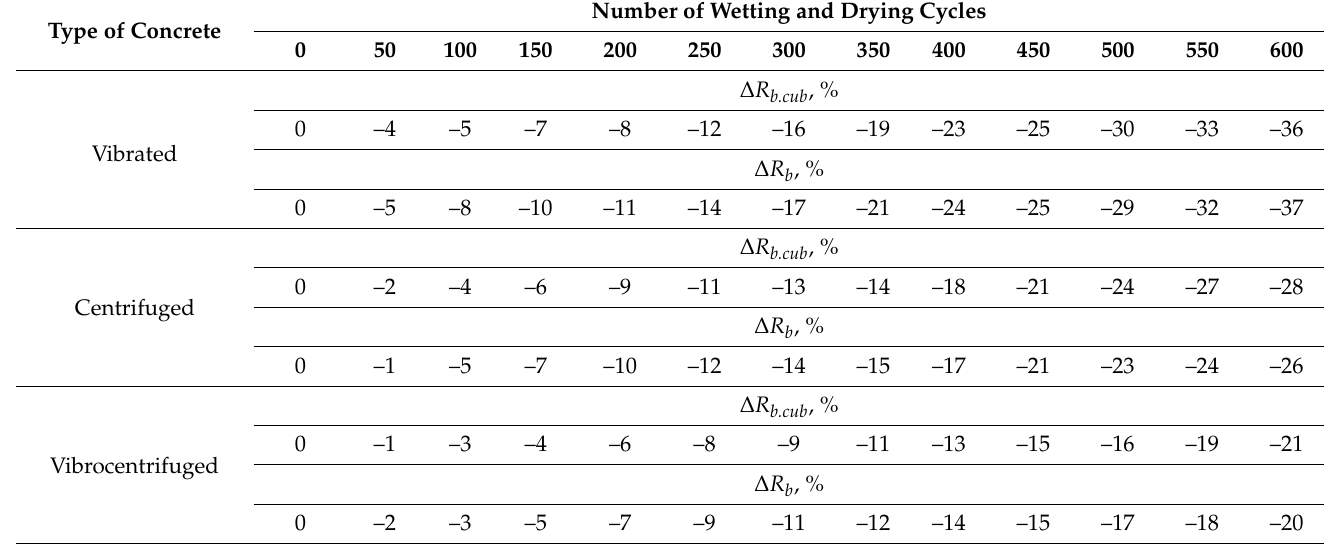
Table 6. Change in the strength characteristics of vibrated, centrifuged, and vibrocentrifuged con- cretes after cyclic wetting and drying at pH